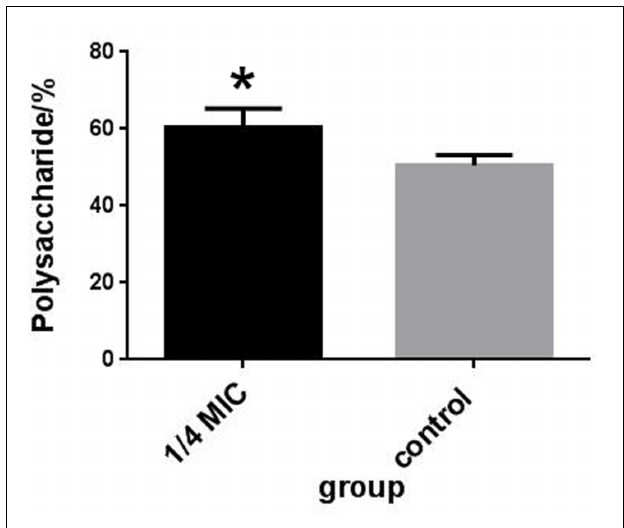
FIGURE 5 | Mapping of the cps in the genome of S. suis by PCR. The 1–21 stands for cps2A–2U , respectively.